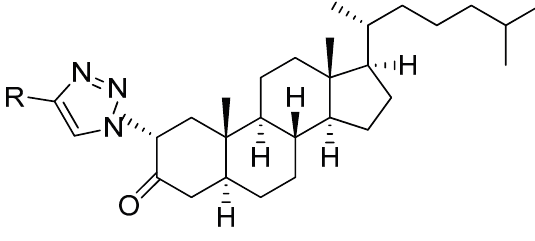
Figure 2. 2 α -Triazole-5 α -cholestan-3-one.